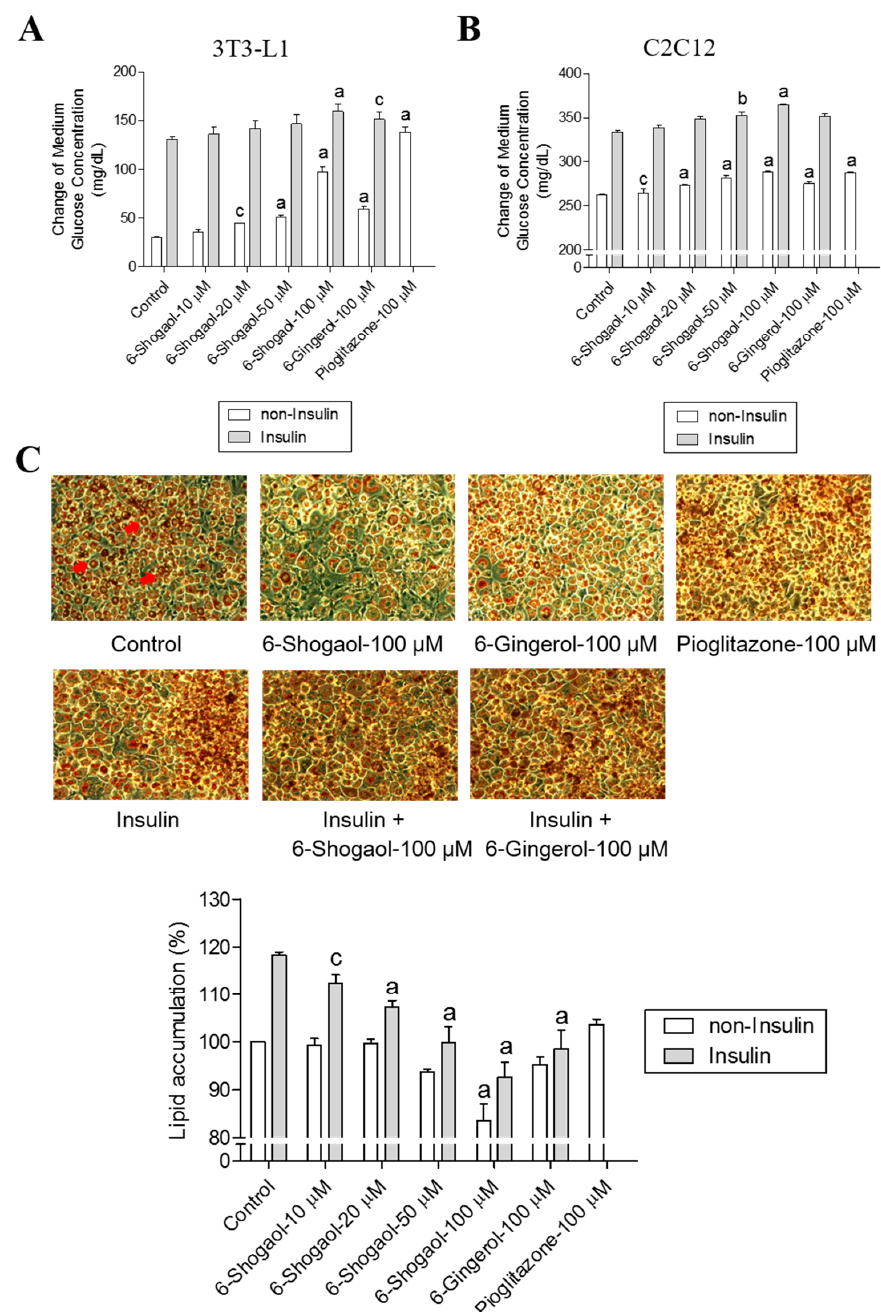
Figure 2. 6-Shogaol promotes medium glucose consumption in 3T3-L1 adipocytes and C2C12 myotubes and inhibits lipid synthesis in 3T3-L1 adipocytes. Medium glucose consumption in 3T3-L1 adipocytes ( A ) or C2C12 myotubes ( B ) in response to the treatment of different concentrations of 6-shogaol and 6-gingerol without or with insulin (0.32 μ M) in 450 mg/dL D -glucose DMEM. After 24 h, the remaining glucose concentration of the medium was measured using a chemistry analyzer. The data represent the amount of glucose in mg/dL consumed by the cells after 24 h of treatment. 6-Gingerol (100 μ M) and pioglitazone (100 μ M) were used as the positive controls. ( C ) Oil Red O staining of lipid droplets in 3T3-L1 adipocytes (magnification 200×). Data reflect the mean ± SEM of three independent experiments. The red arrows indicate examples of stained oil drops in adipocytes (see the control picture). a p < 0.001, b p < 0.01 and c p < 0.05 indicate a significant difference compared with the control group.